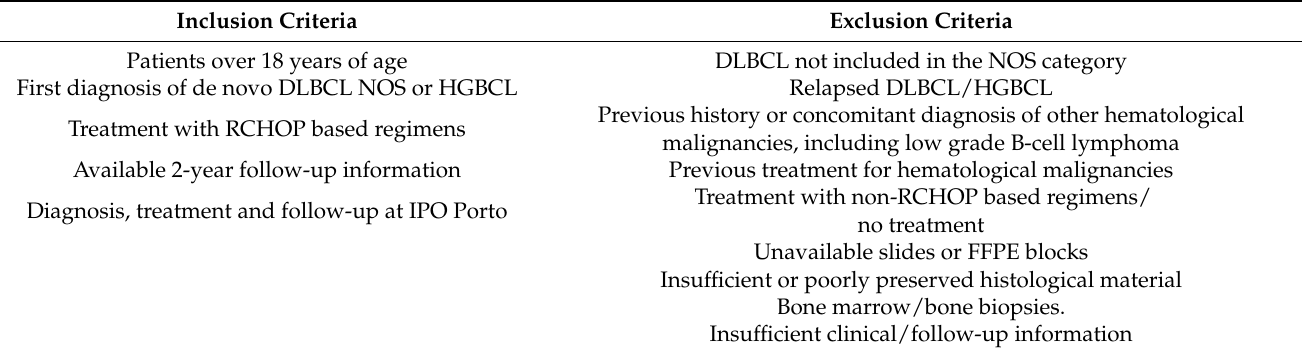
Table 1. Outline of inclusion and exclusion criteria.